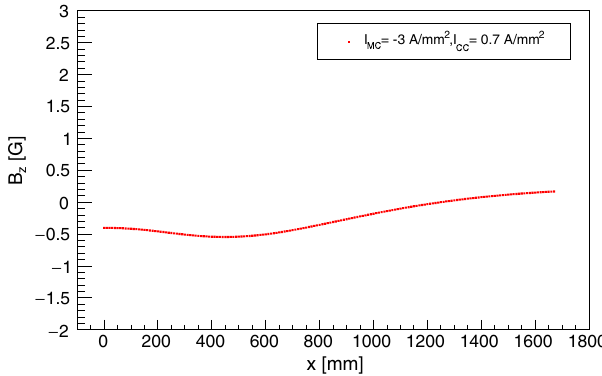
FIG. 18. Comparison of magnetic fields of the G4beamline solenoid and the OPERA model-3: (a) B z along the solenoid central axis; (b) B r at the maximum aperture r ¼ 20 cm. Both the fields of two solenoids have been normalized to have the same focusing